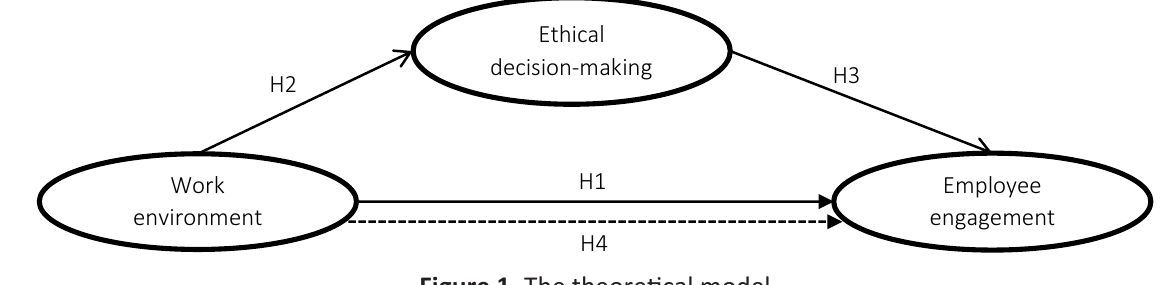
Figure 1 . The theoretical